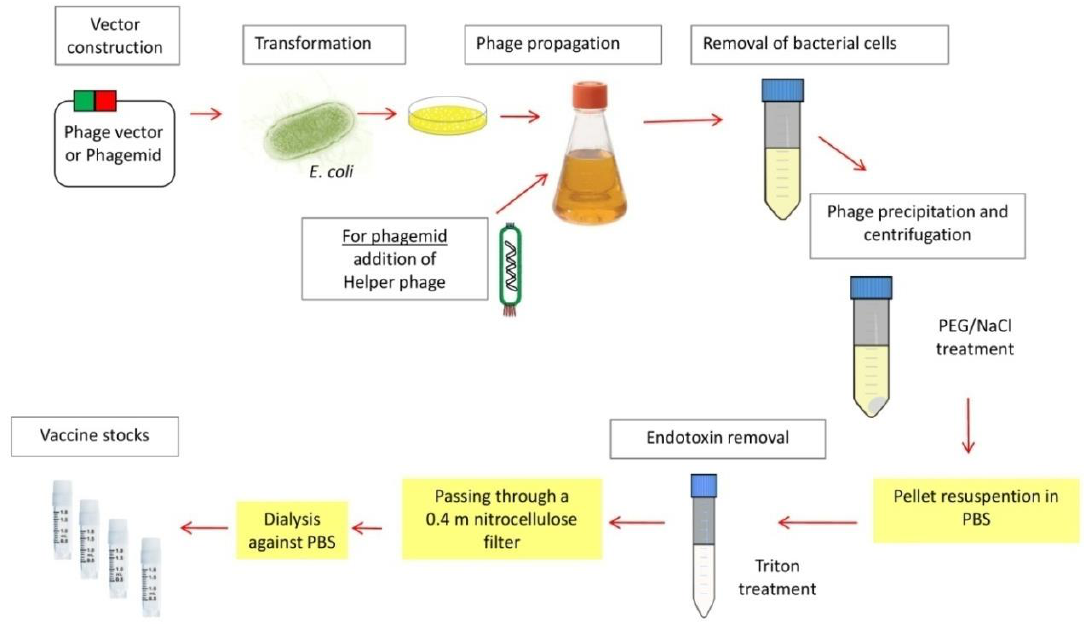
Figure 2. Schematic of the preparation for M13 phage-based vaccine.